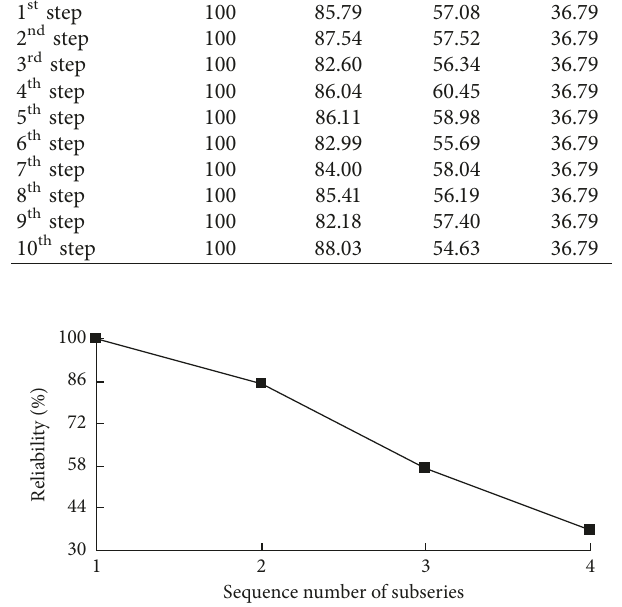
Figure 13: Accuracy maintaining reliability at the end of each